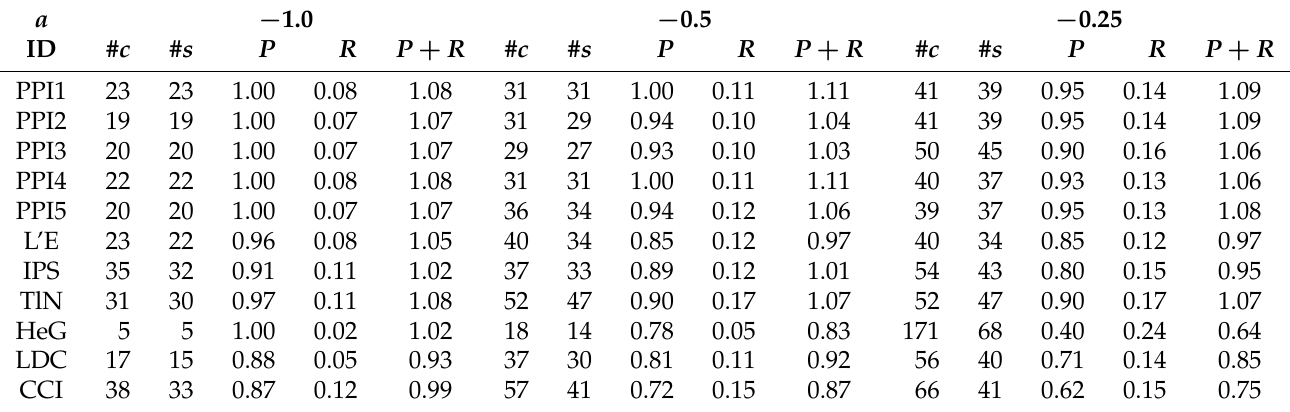
Table 8. Performance of cutoff assessment on single Italian